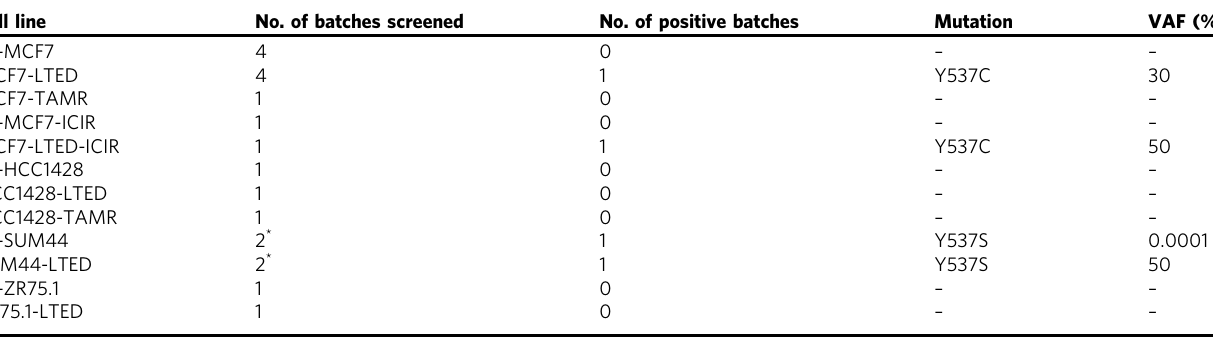
Table 1 Identi fi cation of naturally occurring ESR1 mutations in cell line models of endocrine sensitive and resistant breast cancer Cell